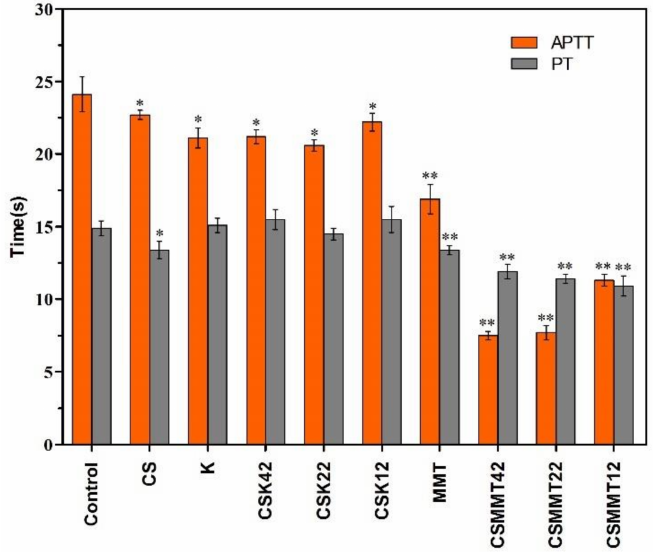
Figure 4. APTT and PT of control, CS, K, CSK42, CSK22, CSK12, MMT, CSMMT42, CSMMT22, and CSMMT12. Data represent the mean ± SD ( n = 5). * p < 0.05; ** p < 0.01, compared to control.